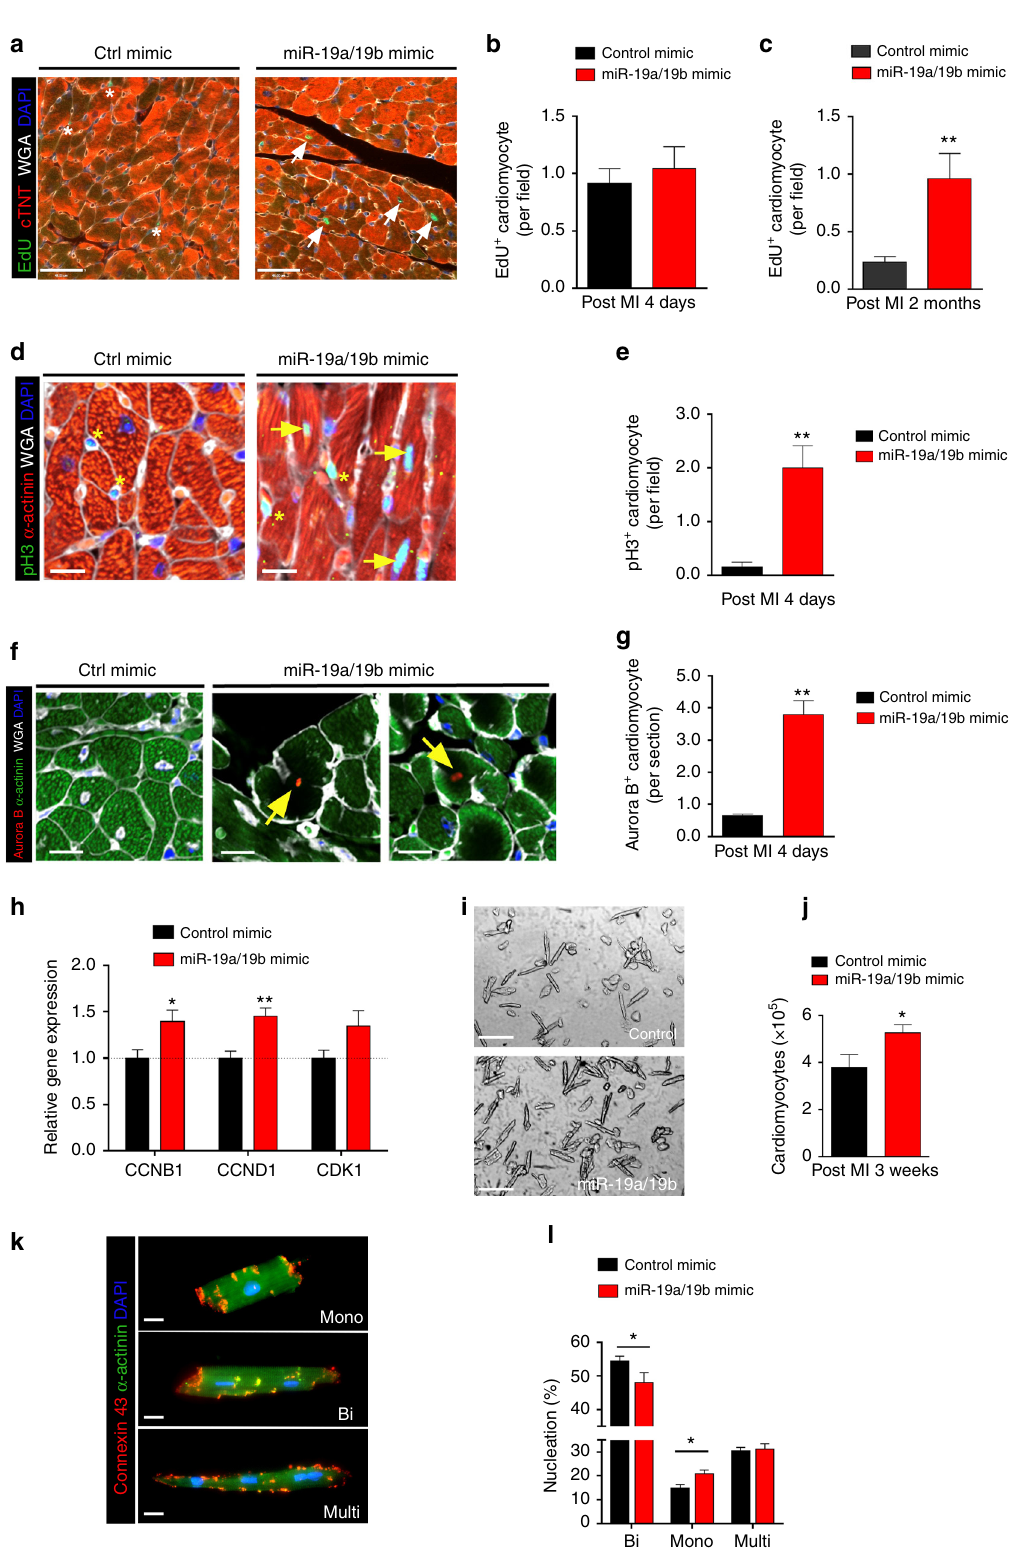
related to immune response, defense response, and T cell (Fig. 5h). Additionally, genes related to extracellular matrix, collagen network, and integrin signaling pathway are